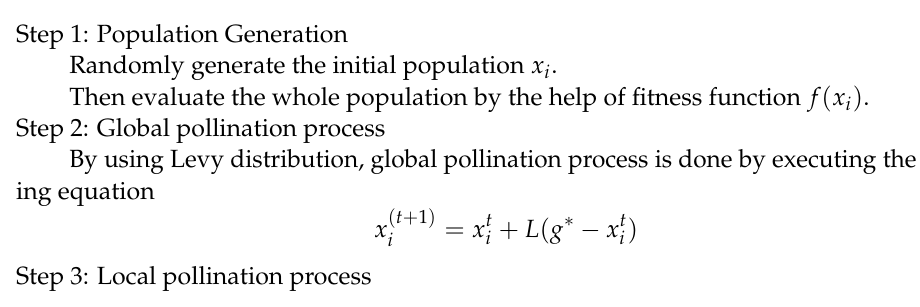
Figure 2. Flow diagram for Flower Pollination